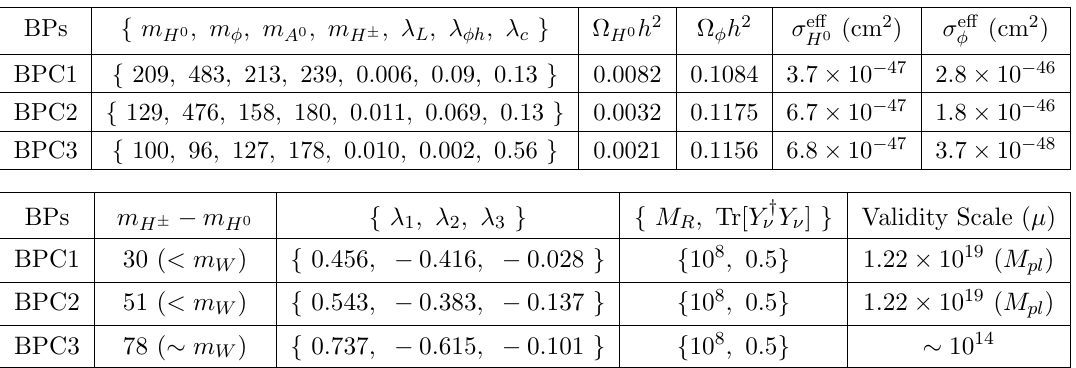
Table 4 . DM masses, quartic couplings, relic densities and spin independent e(cid:11)ective DM-neucleon cross-section of selected benchmark points for collider study. All benchmark points chosen here have m (cid:0) m < m for o(cid:11)-shell production of W (cid:6) . The maximum scale ( (cid:22) ) of Higgs vacuum H 0 H (cid:6) W (cid:6) satability and peturbativity in presence of right handed neutrinos are also noted. All masses and scales are in GeV.